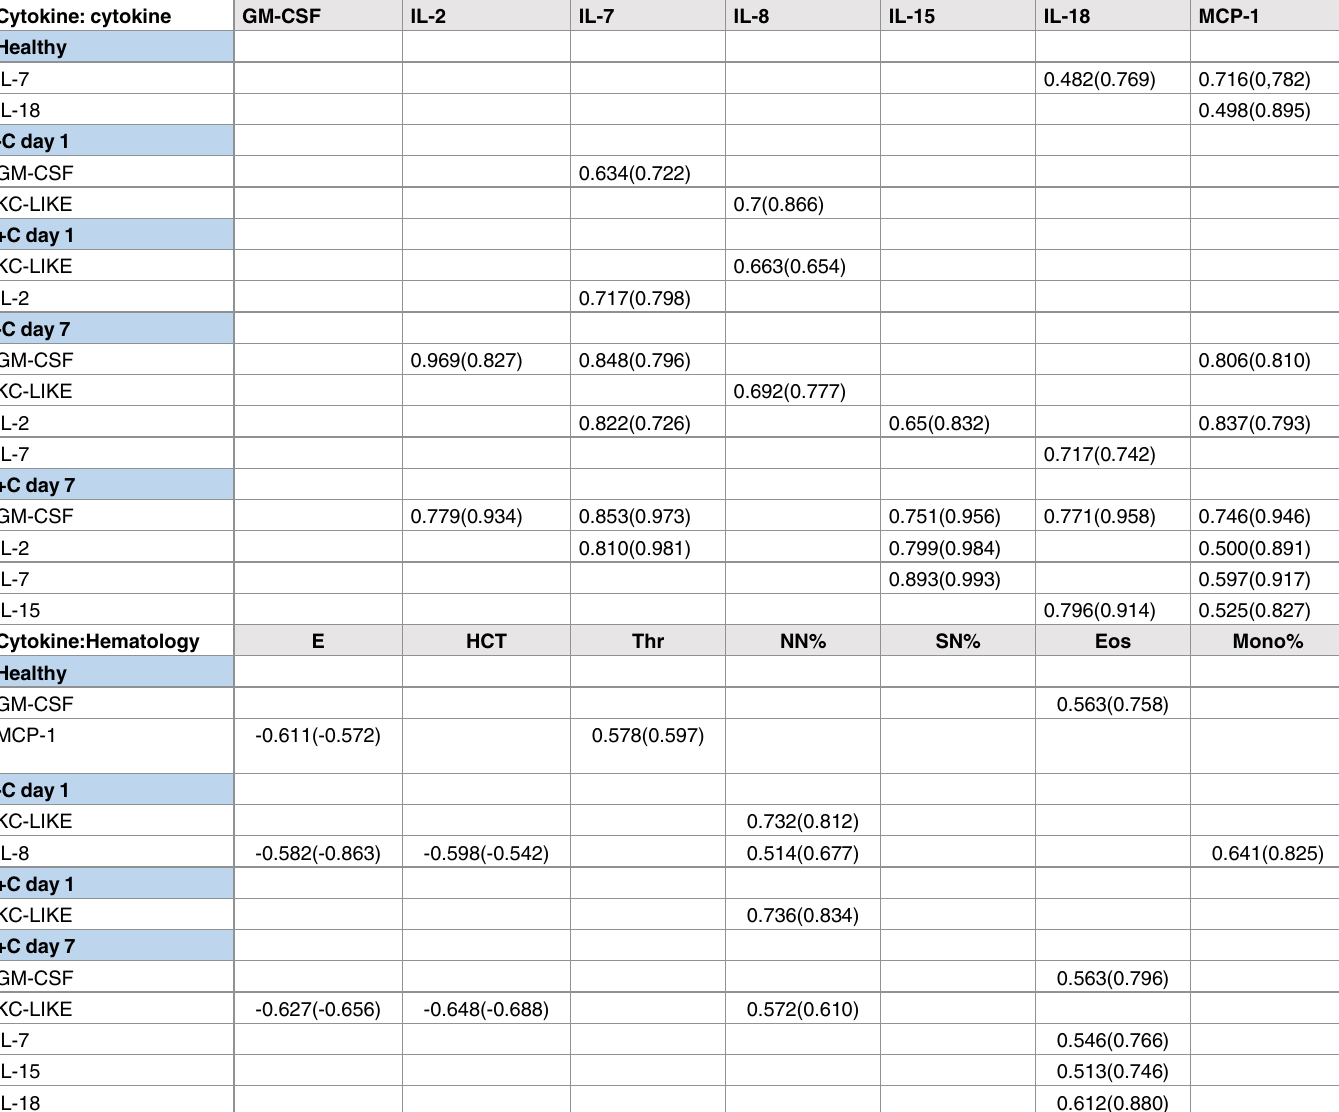
Table 3. Highest Spearman’ s rank and Pearson’s product moment correlation coefficients (r s and r). Highest values for r s and r (in brackets) for cyto- kine:cytokine and cytokine:hematologic parameter within different groups. E: Erythrocyte count, HCT:Hematocrit, Thr: Thrombocyte count, NN: Non-seg- mented neutrophilcount SN: Segmented neutrophilcount, L: Leukocytecount, Eos: Eosinophil